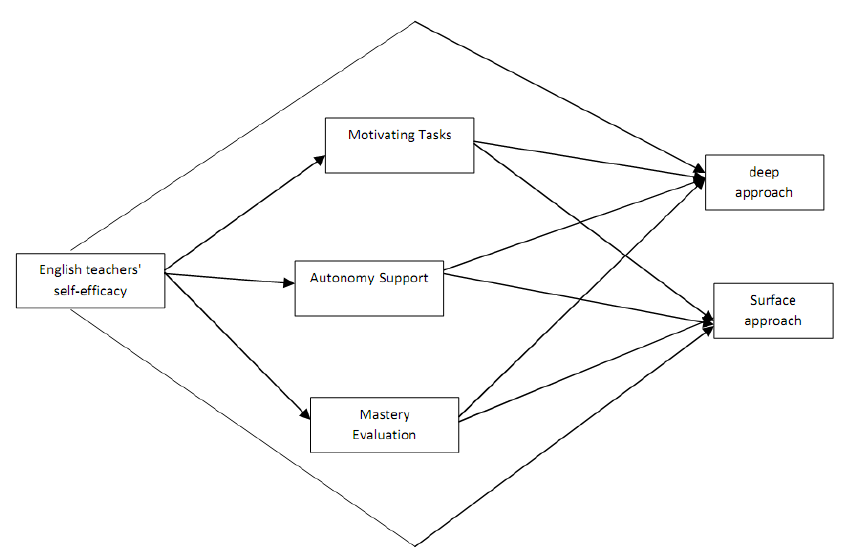
Figure1 : suggested model for relationship between teacher efficacy, students' perception of classroom structure and their learning approaches